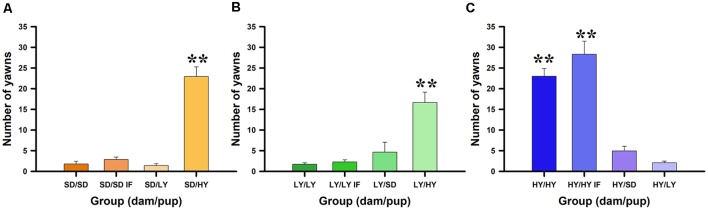
Spontaneous yawning frequency dependents on the dam that take care of male rats. (A) Sprague-Dawley (SD) dams do not change the behavioral trend, being the high yawners male rats belonging from HY subline independently of the dam that raised them, see pairs dam/male rats SD/HY (panel A), LY/HY (panel B), and HY/HY or HY/HY IF (panel C); **P < 0.01. Note that LY dams can reduce yawning frequencies in all pairs LY/LY, LY/LY IF or LY/SD (panel B). Contrary, HY dams do not increase yawning frequencies in SD or LY male rats (see HY/SD and HY/LY; panel C).